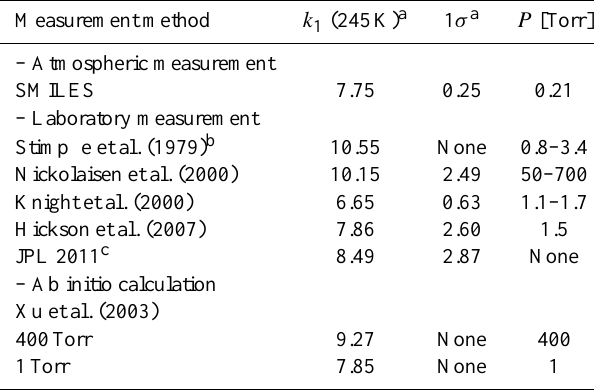
Table 2. Comparison with previous